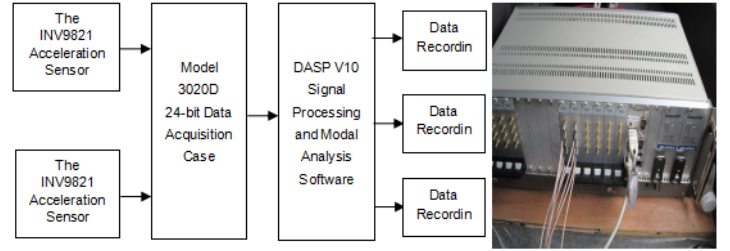
Fig. 4 Composition of test and analysis system and signal acquisition instrument.